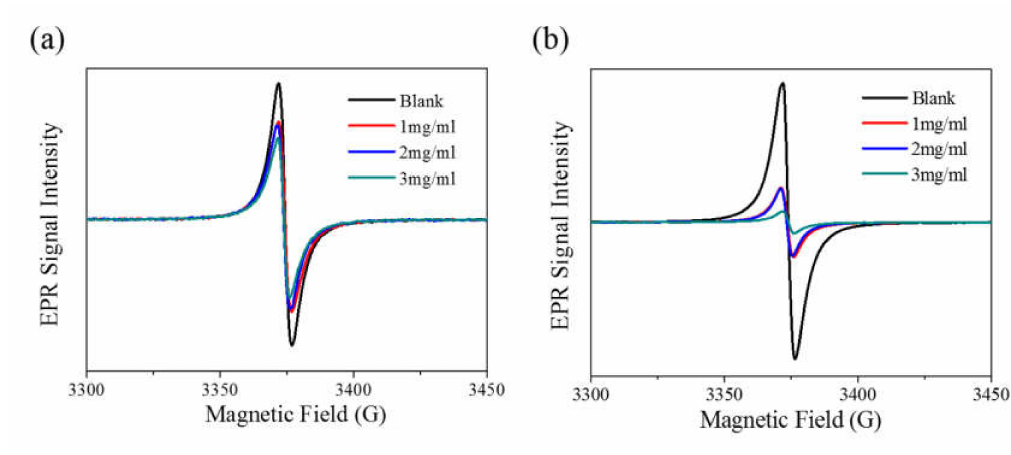
Figure 8. Comparison of electron paramagnetic resonance (EPR) spectra of ( a ) apple extract and ( b ) AuNPs encapsulated in carbon nanosheets at di ff erent